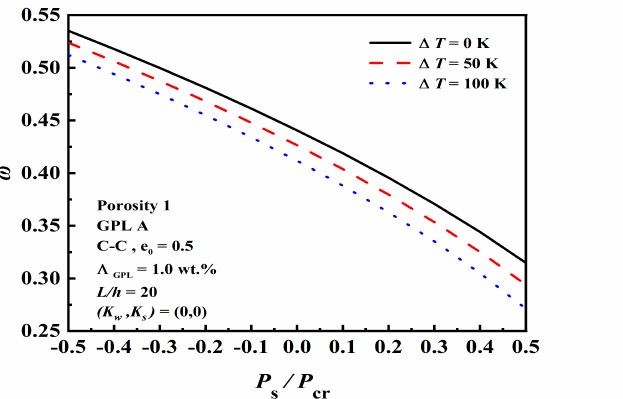
Figure 9. Effect of normalized static axial force P s / P cr on the dimensionless fundamental frequency under initial thermal loading ∆ T